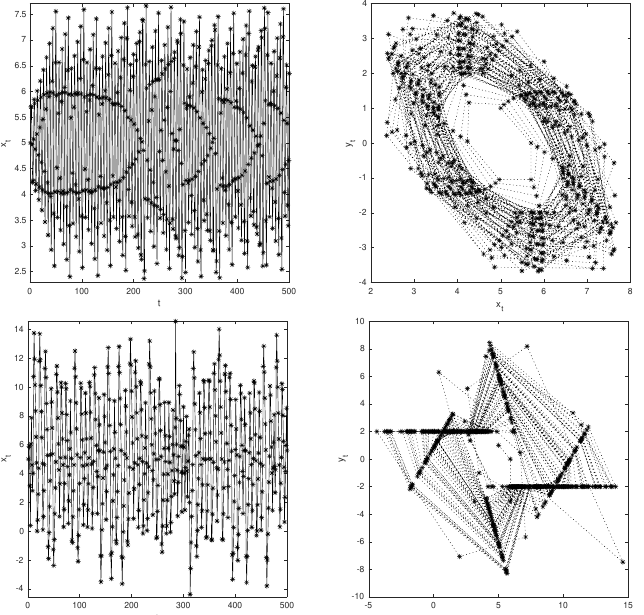
= 1.4286; while ( bottom-left ) and ( bottom- b